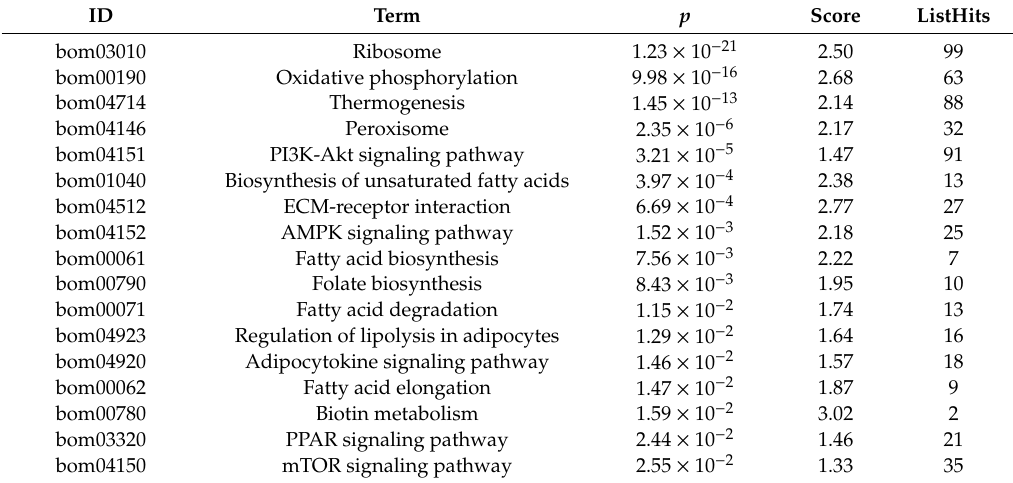
Table 4. The kyoto encyclopedia of genes and genomes (KEGG) pathways related to fat metabolism in the subcutaneous fat of yaks under long-term ES.